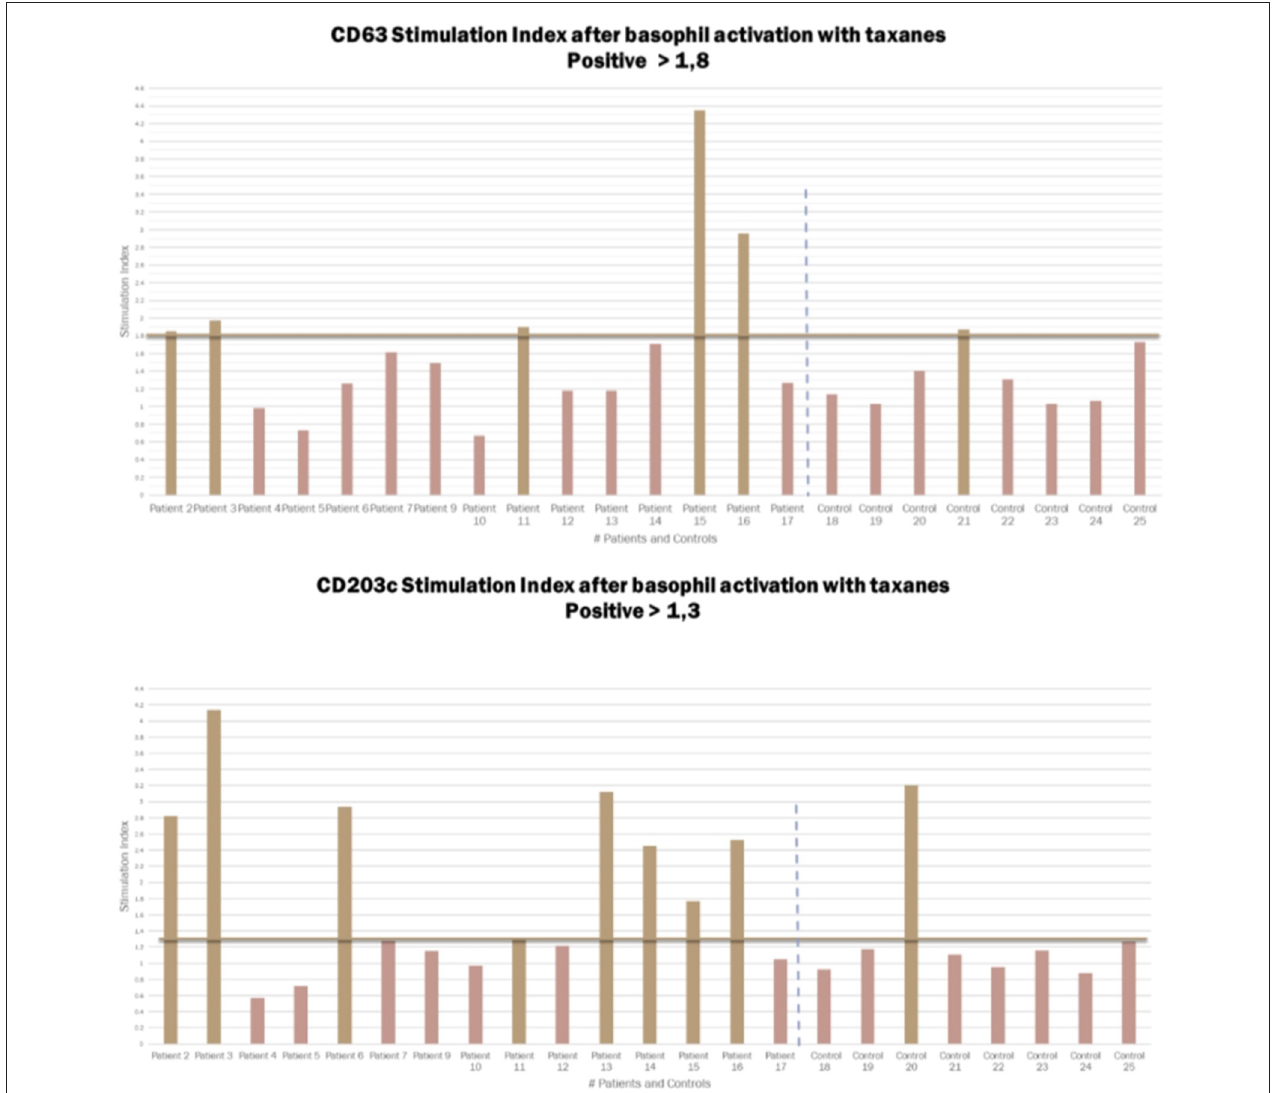
FIGURE 3 | Graphic representation of the Stimulation index from the CD63 and CD203c expression in patients and controls after basophil activation with taxanes. Cut-off for CD203c 1.3 and for CD63 1.8.